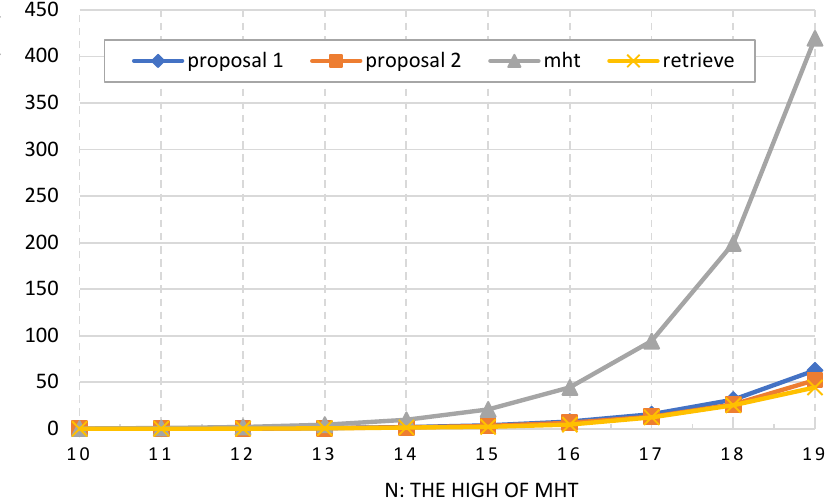
Figure 6. The performance evaluation of the proposed schemes for authenticating 2 𝑛 segments.